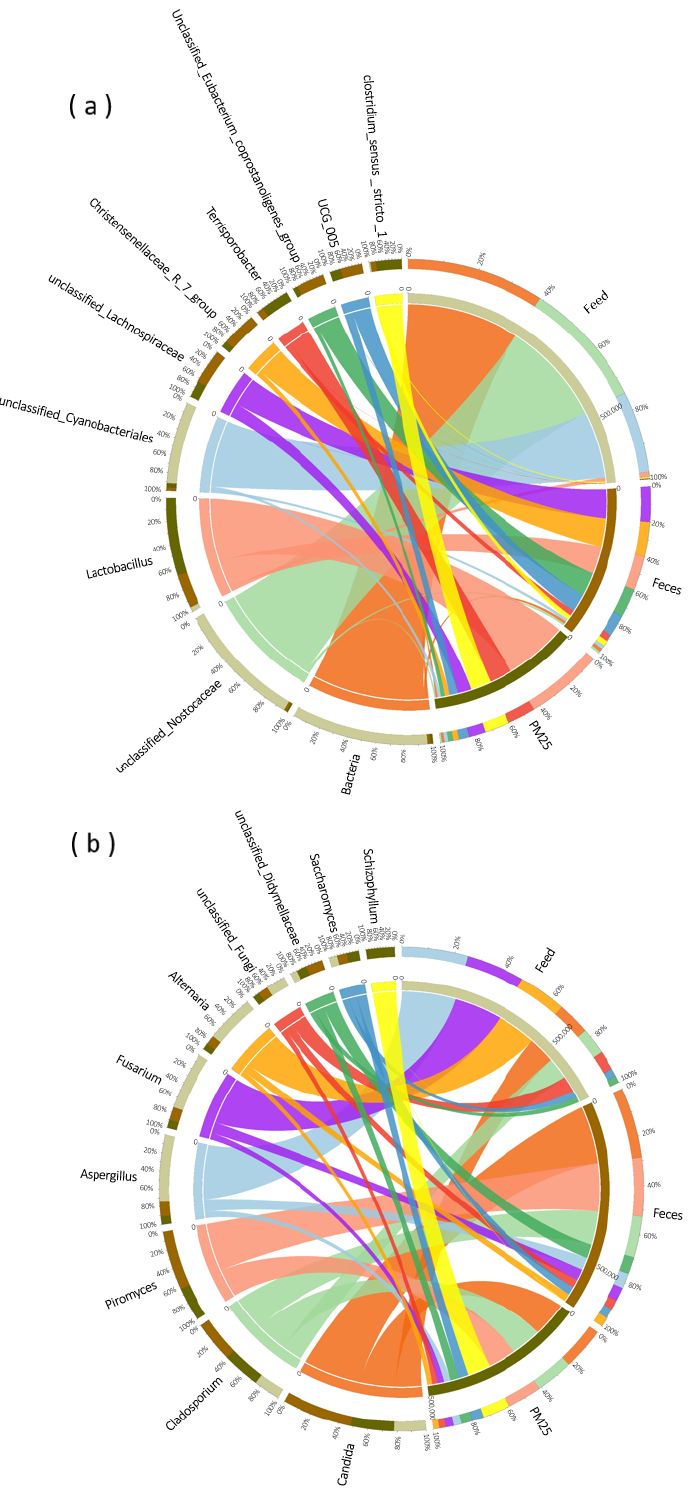
Figure 4. Species composition of bacteria ( a ) and fungi ( b ) in PM 2.5 , feed and feces samples.